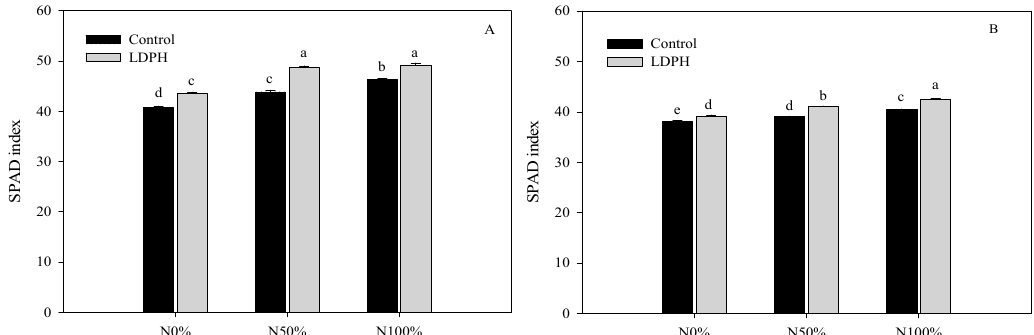
Figure 2. The SPAD index of baby spinach ( A ) and lamb’s lettuce plants ( B ) as affected by nitrogen (N) fertilization levels (0, 2.25 and 4.5 g N·m − 2 and 0, 2.5 and 5.0 g N·m − 2 ; N0%, N50%, N100%, respectively) and biostimulant application (non-treated control and LDPH: Legume-derived protein hydrolysates). Different letters indicate significant differences according to the DMR test ( p < 0.05). Vertical bars indicate ± standard error of means.